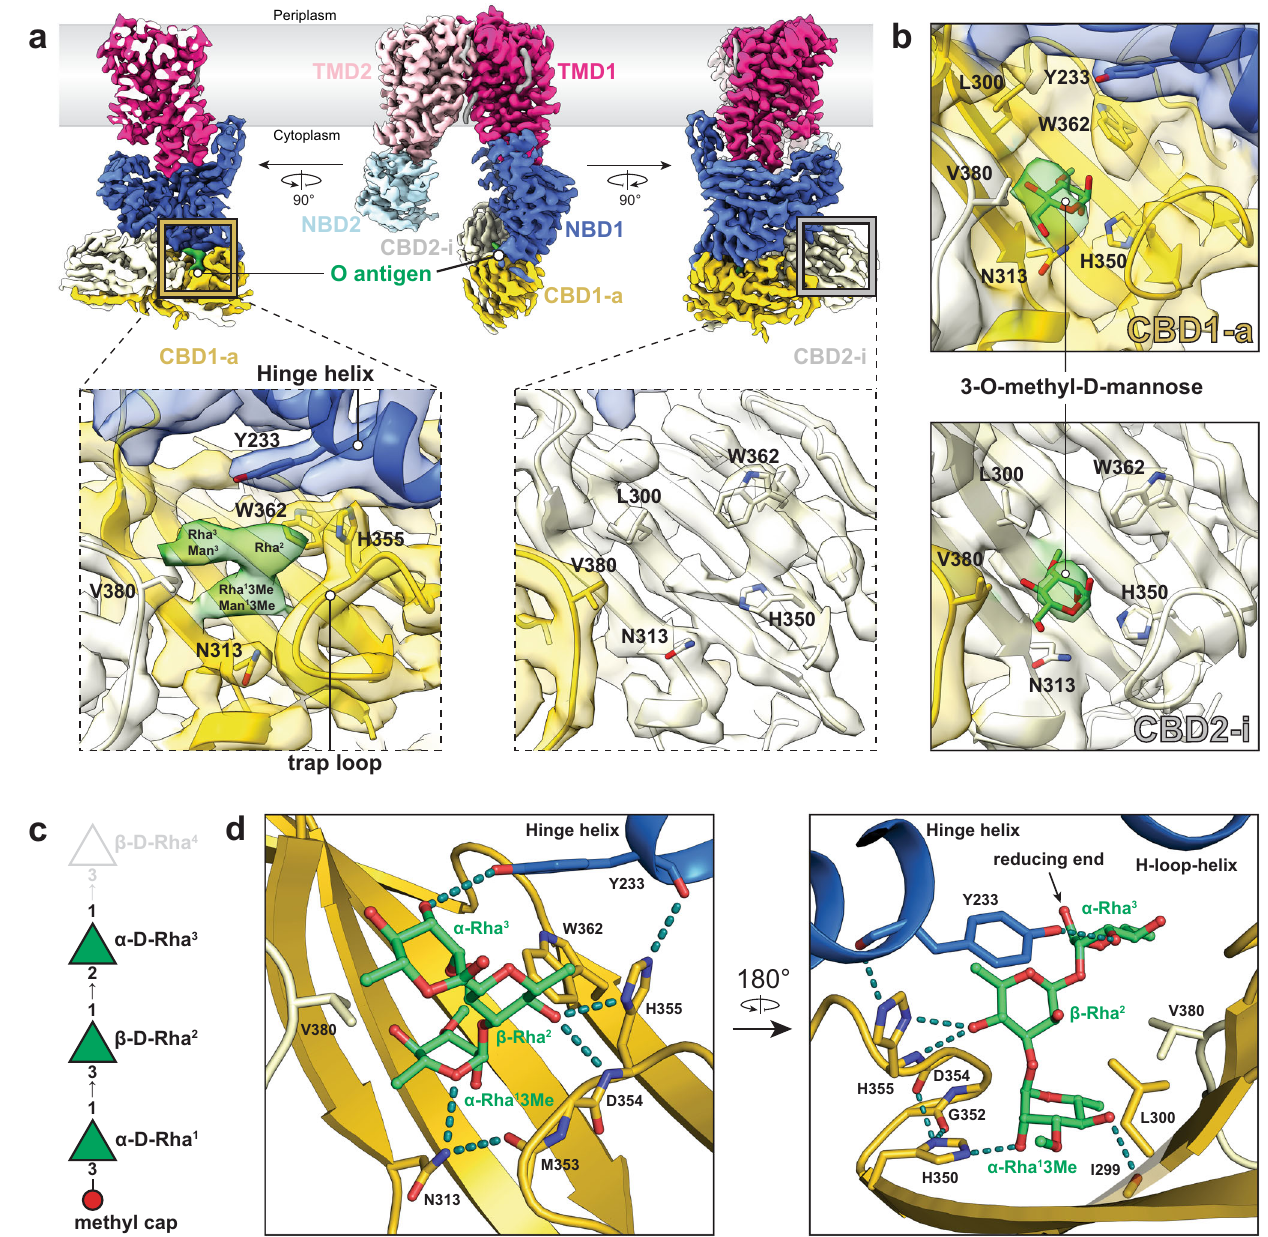
Fig. 4 | Cryo-EM structureofWzmWzt in complex with A.aeolicus Oantigenor 3- O -methyl- D -mannose. a Coulombic potential map of WzmWzt in complex with puri fi ed A. aeolicus O antigen. Three different side orientations are shown. Boxed panels show local density within the cap-binding site for CBD1-a and CBD2-i. Den- sity for O antigen is colored in green; contour level: 8.9 σ . b Panels show local density within the cap-binding site for CBD1-a and CBD2-i from the 3- O -methyl- D - mannose bound WzmWzt map. Density for 3- O -methyl- D -mannose is colored in green.; contour level: 7.2 σ (CBD2-i site) and 5.4 σ (CBD1-a site). c Model substrate